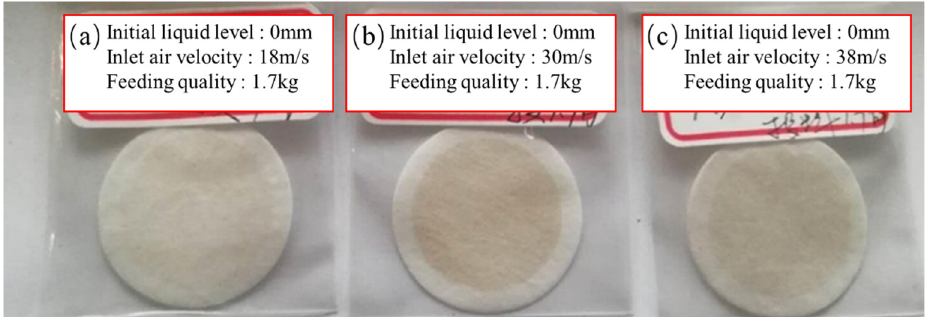
Figure 8. Pictures of filter membranes after dust sampling at the industrial facility under 3 different operating conditions ( a , b , c ).